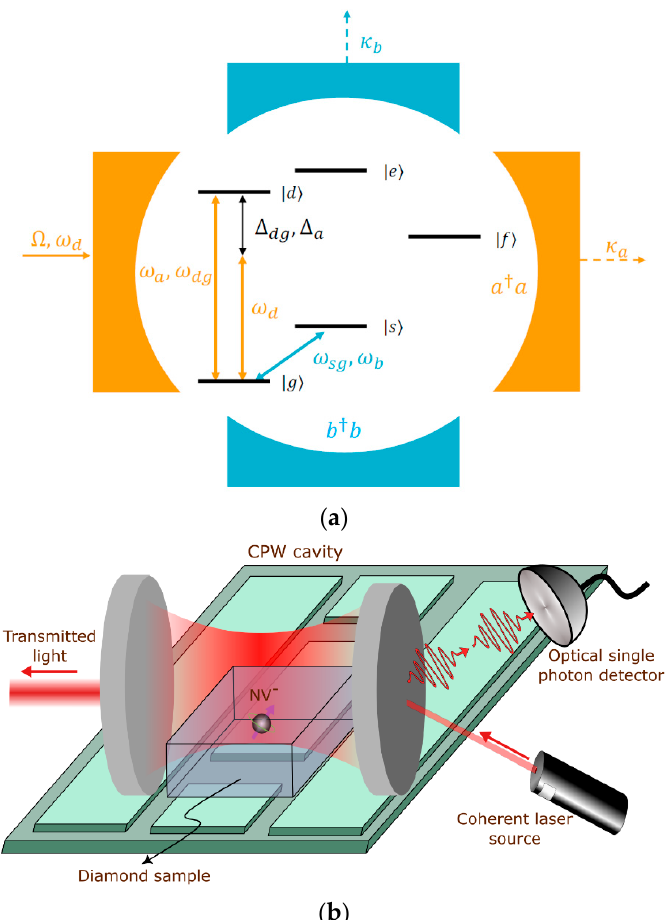
Figure 1. ( a ) Proposed scheme for the detector with a five-level NV center coupled to two cavities; ( b ) illustration of a potential realization of the proposed device using coplanar waveguide (CPW) and a Fabry–Perot cavity.